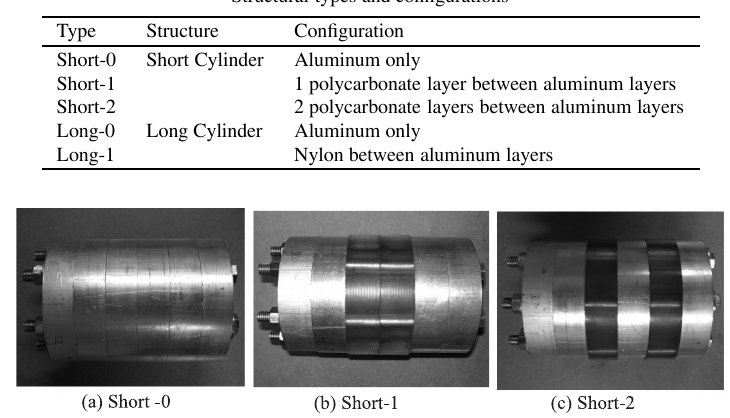
Fig. 2. Three different layer con fi gurations of the short structure used in the experiments; (a) aluminum only, (b) aluminum with a polycarbonate layer in the middle and (c) aluminum and two layers of polycarbonate.